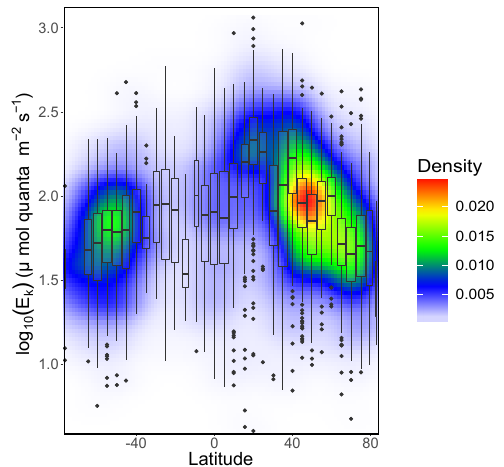
Figure 9. Density plot and box plots showing the variation in the photoadaptation parameter ( E k ) with latitude. Middle horizontal line of boxplot represents the median value and lower and upper boundaries correspond to the first and third quartiles and the length of the whiskers is 1.5 times the inter-quantile range of the bound- ary. Heat map indicates probability density estimates. Filled circles denote